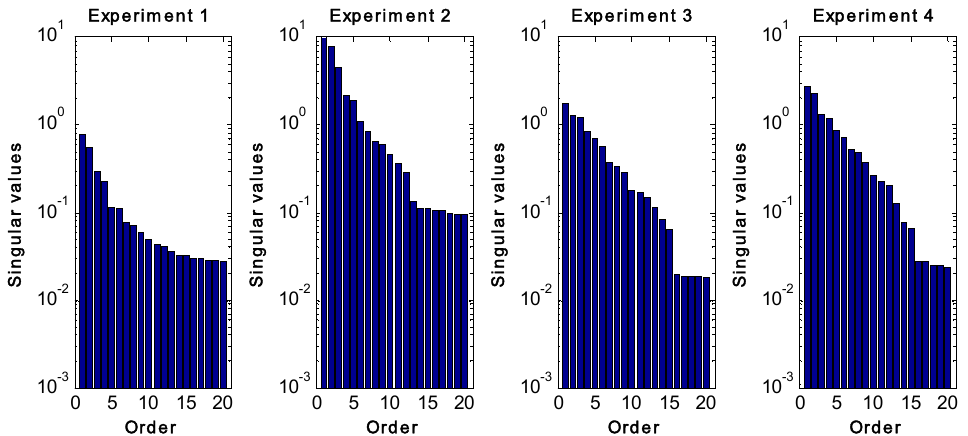
Figure 4. Order estimation for 2 2  distillation column using adaptive DOE with rotated PRBS inputs. A cut ‐ off point is evident at two.